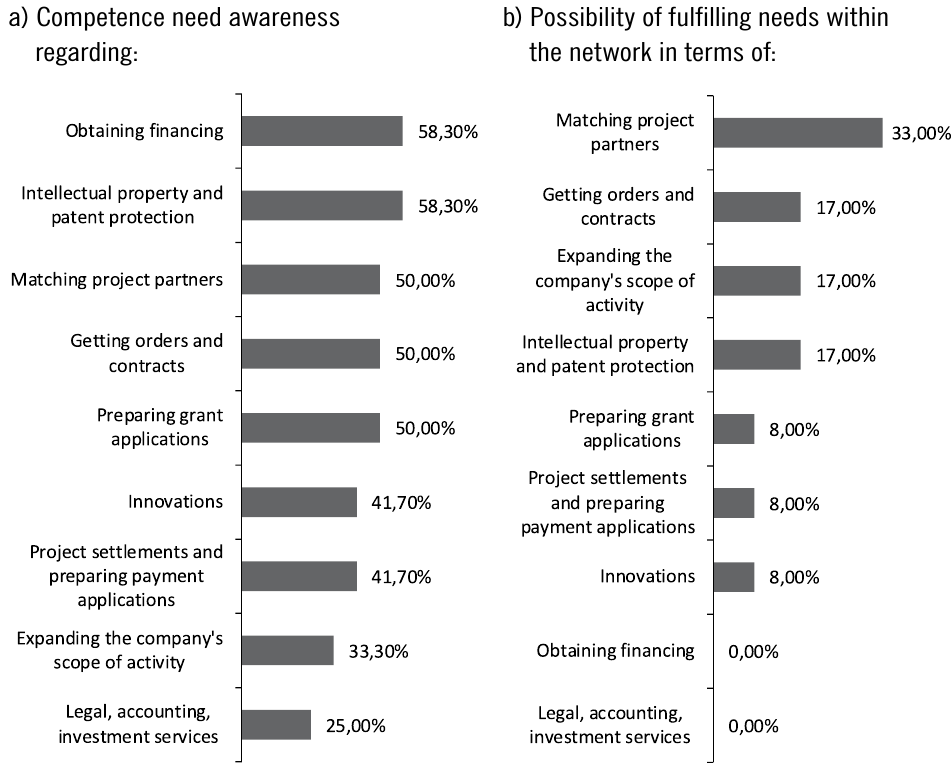
Figure 6. Competence need awareness among companies in terms of